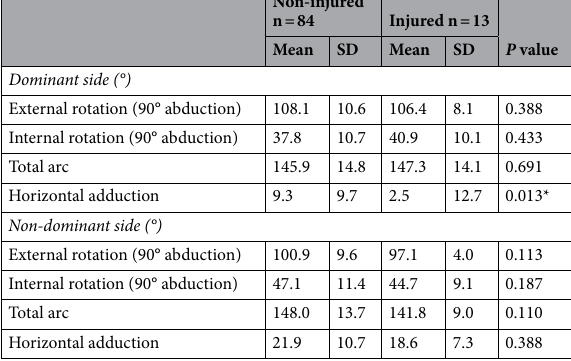
Table 1. Shoulder range of motion. SD, standard deviation. * P <